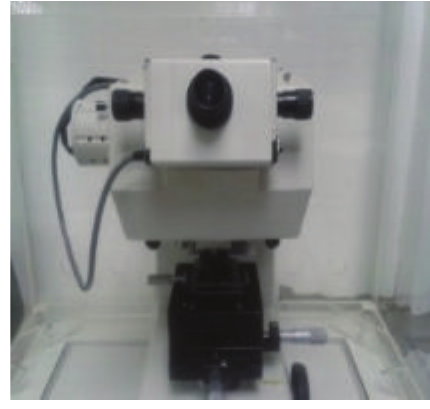
Figure 8: Hardness tester.